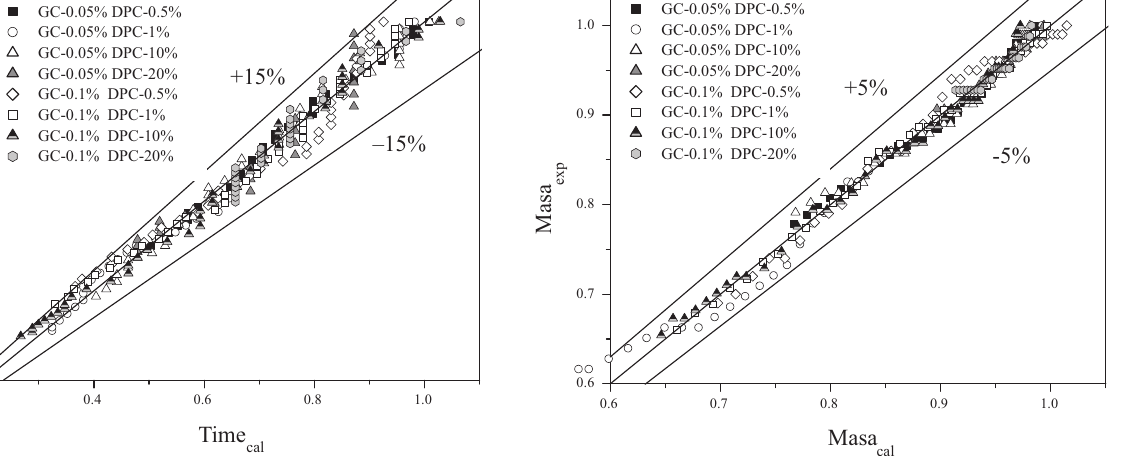
Fig. 6. Correlation between experimental values (massexp) and calculated (masscal) by means of the modified Washburn equation for the second phase of the imbibition process